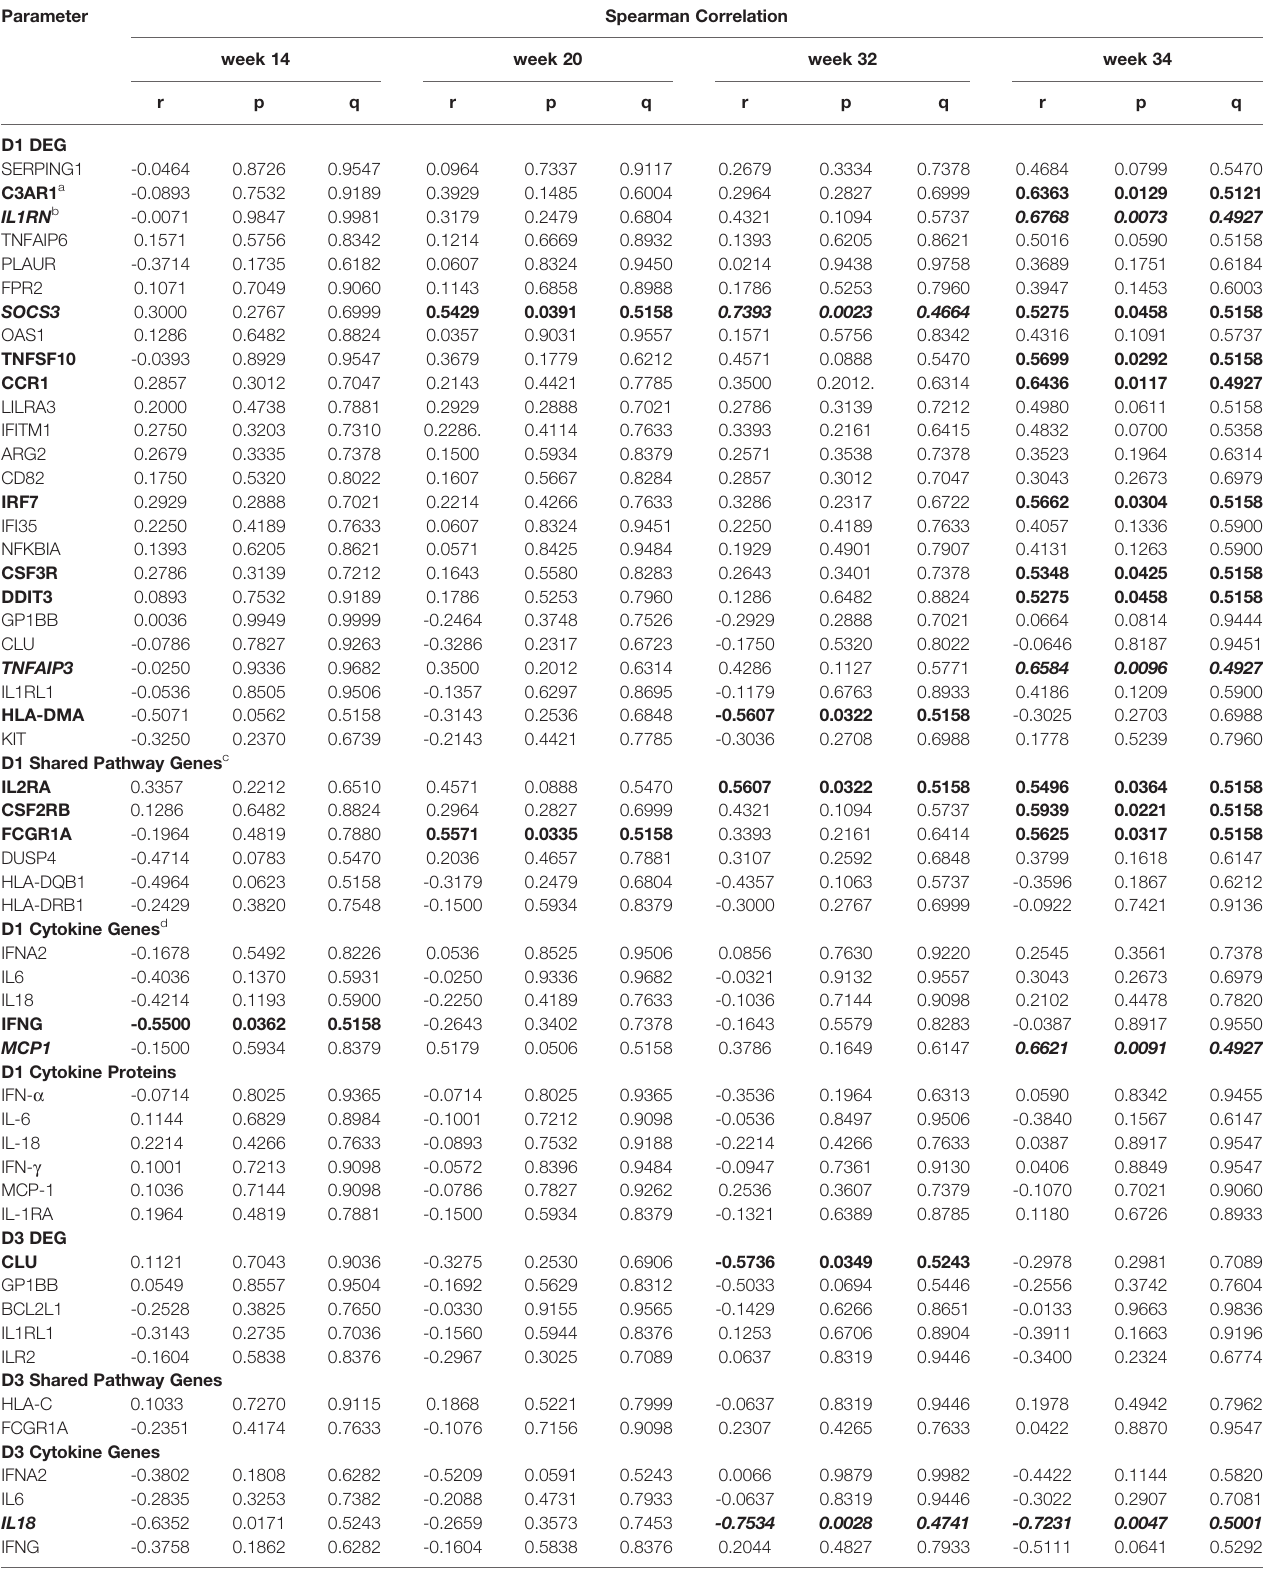
TABLE 4 | Correlation of early gene expression with vaccine-induced Env-speci fi c